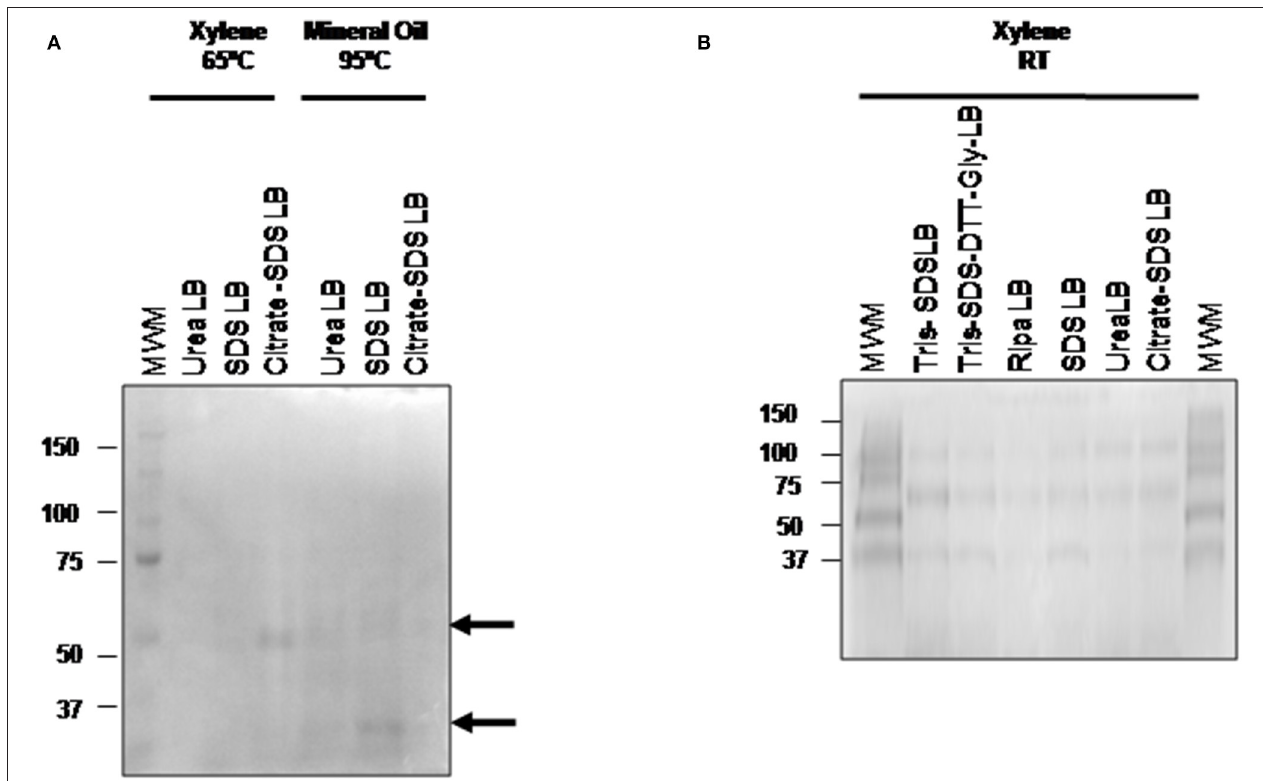
FIGURE 3 | Comparison of the three different deparafinization methods and the protein extraction buffers efficiency. 1D SDS-PAGE 10% gels were performed to evaluate the protein integrity. (A) Visualization of gel protein bands after the deparaffinization with xylene at 65 ◦ C or with mineral oil at 95 ◦ C using the protein extraction buffers: buffer 2 (urea LB), buffer 4 (citrate SDS LB), and buffer 5 (SDS LB). (B) Visualization of gel protein bands after the deparaffinization with xylene at RT using the protein extraction buffers: buffer 1 (TRIS SDS LB), buffer 2 (urea LB), buffer 3 (TRIS SDS DTT GLY LB), buffer 4 (citrate SDS-LB), buffer 5 (SDS LB), and